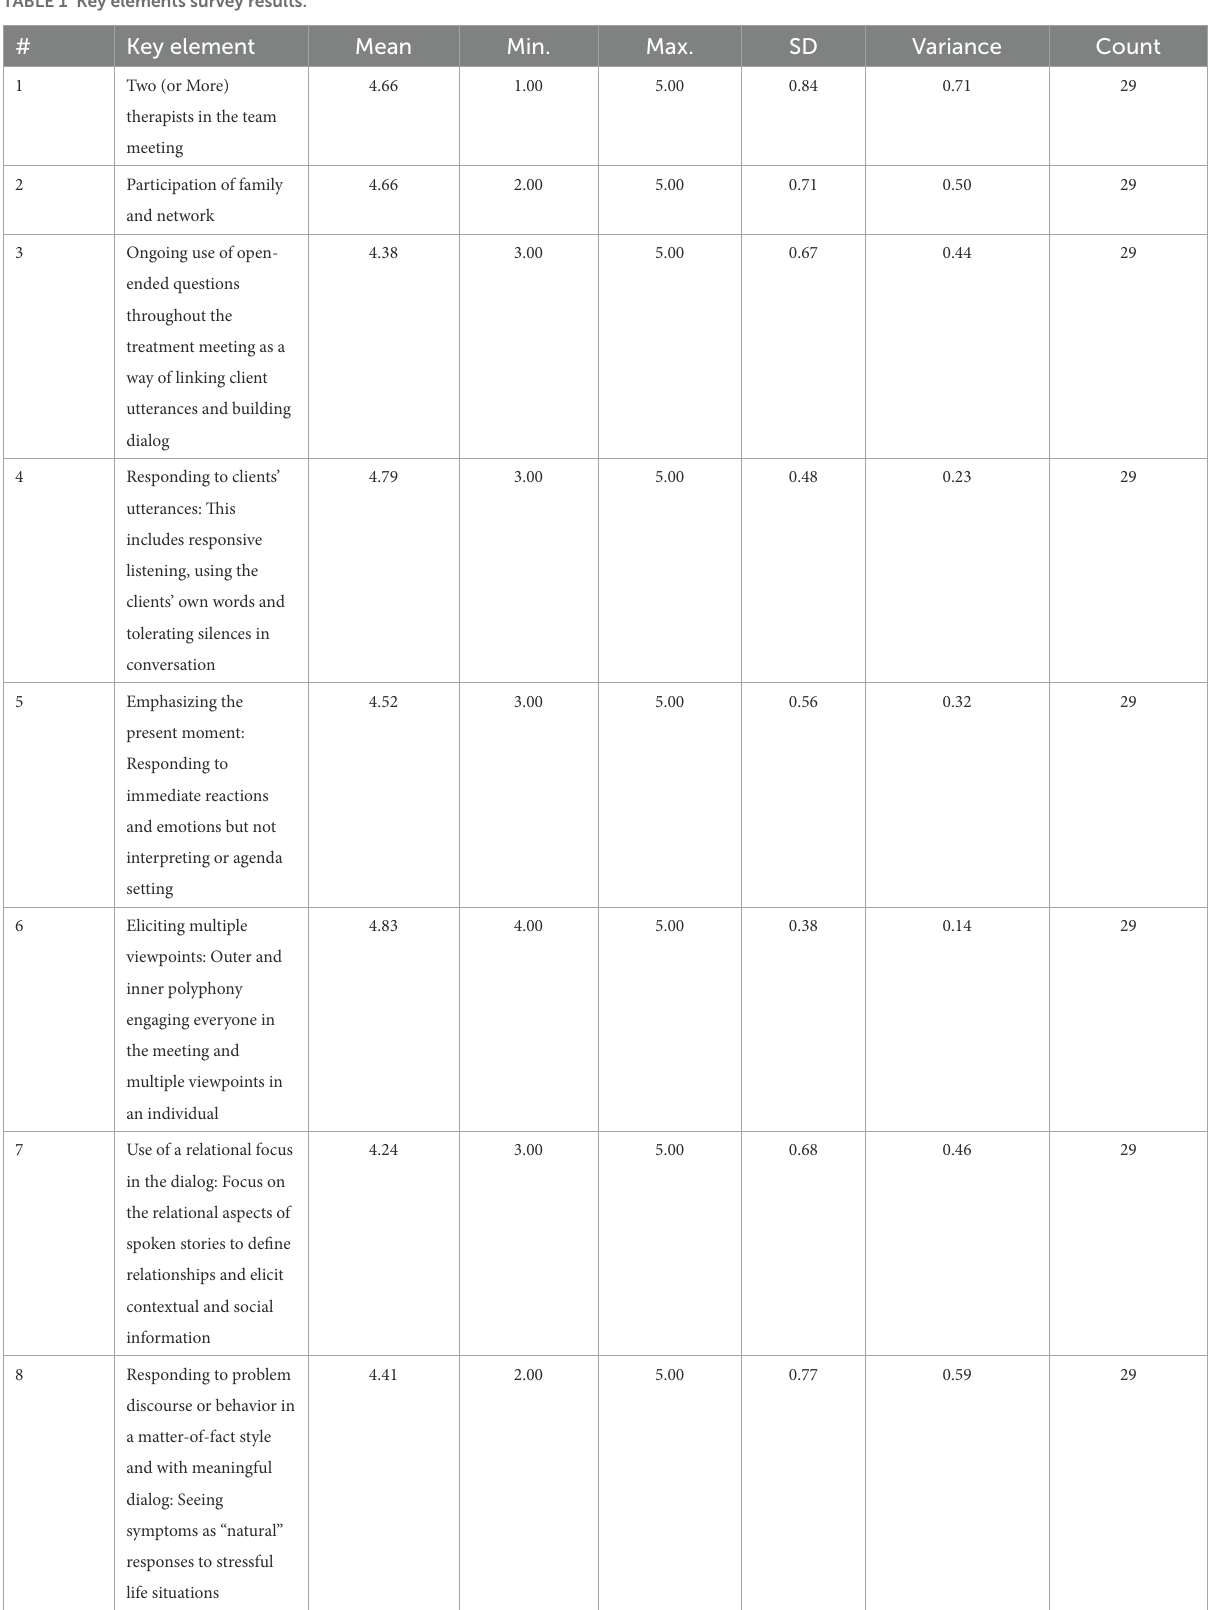
TABLE 1 Key elements survey